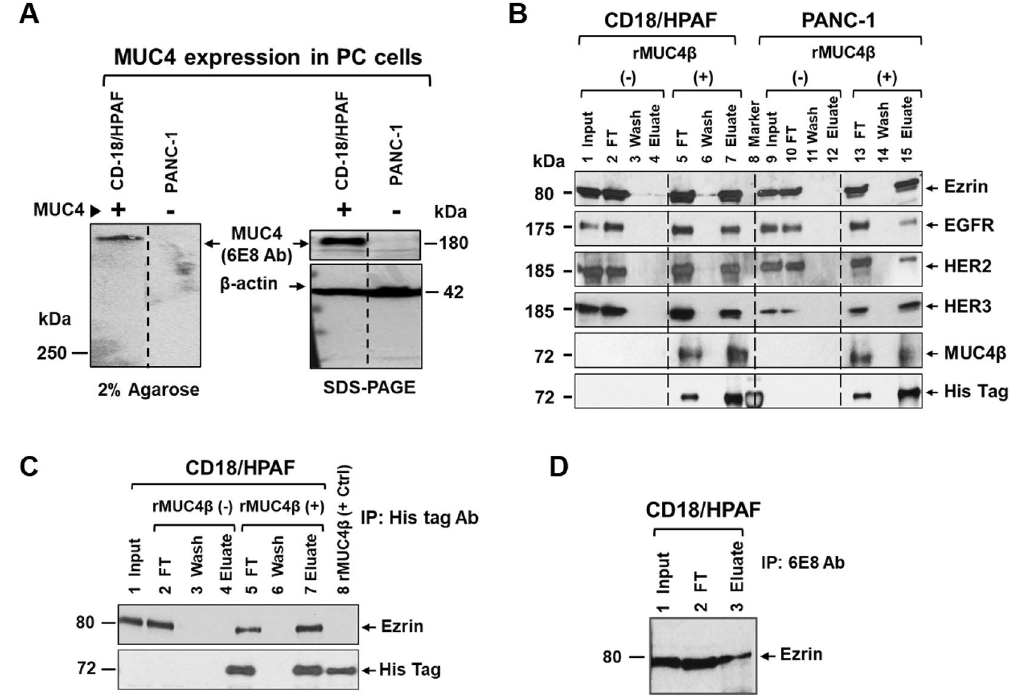
Figure 4. Detection and confirmation of the new and known interacting partners of MUC4 via immunoblotting and IP analyses. ( A ) Expression profile of MUC4 in CD18/HPAF and PANC-1 cells determined by immunoblotting following 2% agarose gel electrophoresis and 10% SDS-PAGE. ( B ) Immunoblot analyses of Ni-NTA pull-down fractions from CD18/HPAF or PANC-1 cell lysates in the presence (+) or absence (−) of rMUC4β. The blots were probed with the indicated antibodies. Input, flow-through (FT), wash, and eluate are the same as described in Fig. 3A. ( C ) Immunoprecipitation using an anti-His tag Ab (clone 27E8) conjugated to magnetic beads following incubation of CD18/HPAF cell lysate in the presence and absence of rMUC4β. ( D ) Interaction of endogenous MUC4 with Ezrin. Immunoprecipitation was performed with